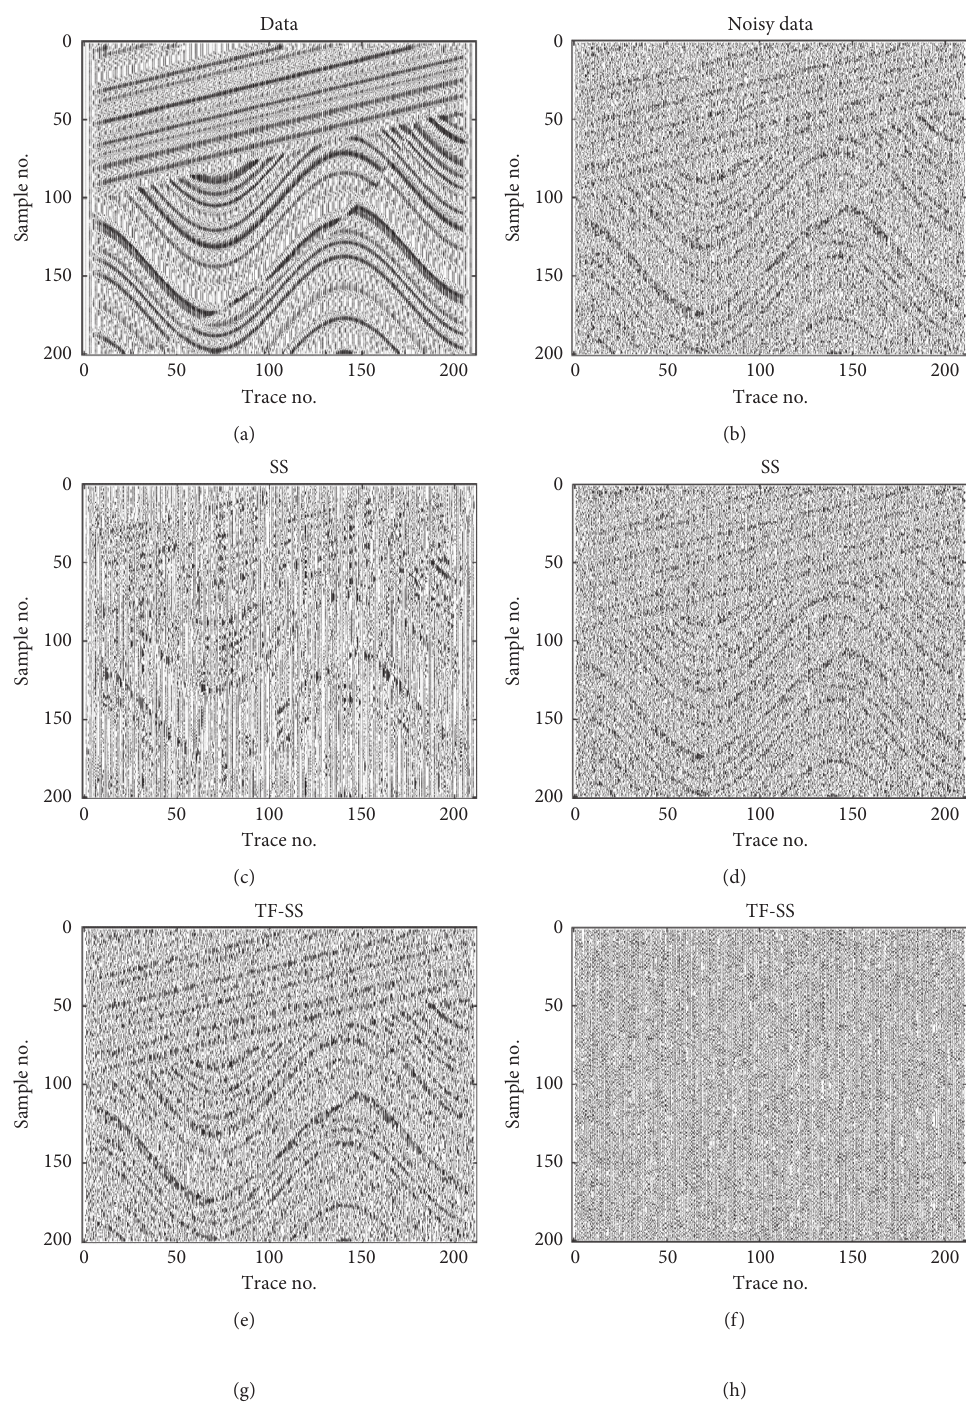
Figure 9: Denoising results of the sigmoid model with Gaussian white noise (S/R � − 6dB). (a) Original seismic record. (b) Noisy seismic record. (c) Denoising by SS. (d) Noise removed by SS. (e) Denoised by TF-SS. (f) Noise removed by TF-SS. (g) Local similarity between (c) and (d). (h) Local similarity between (e) and